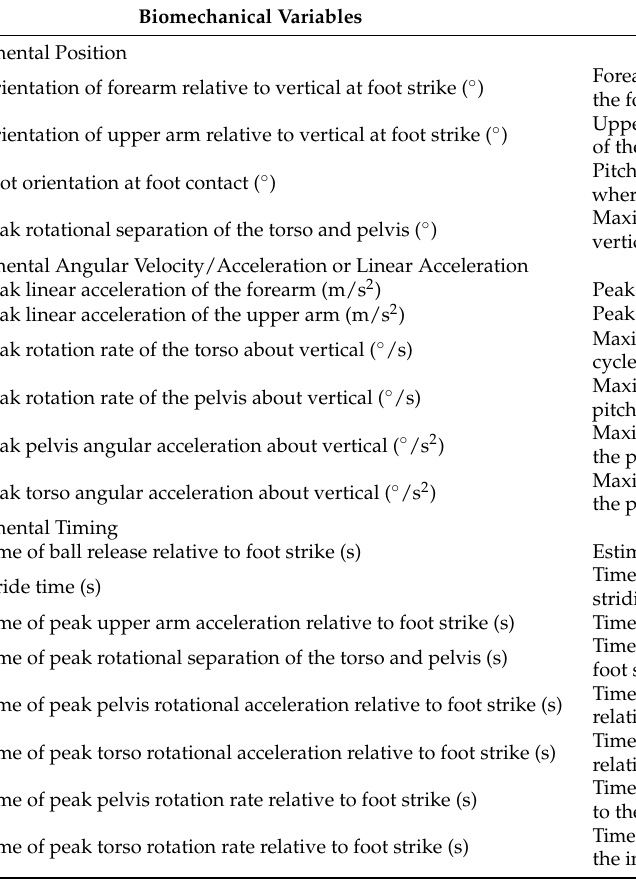
Table 1. Descriptions of biomechanical and pitching variables of interest. Biomechanical variables were calculated from inertial sensor data and are described below. Pitch variables were taken from the Rapsodo output and are described below using information provided in the Rapsodo user manual (Rapsodo, Inc. (2019). Pitching 2.0: User